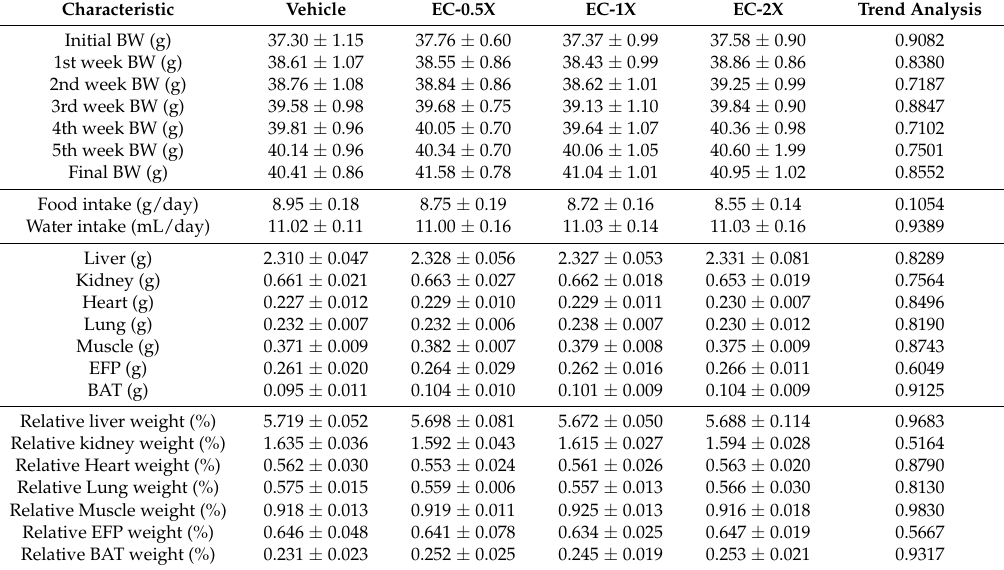
Table 2. General characteristics of mice with EC supplementation.